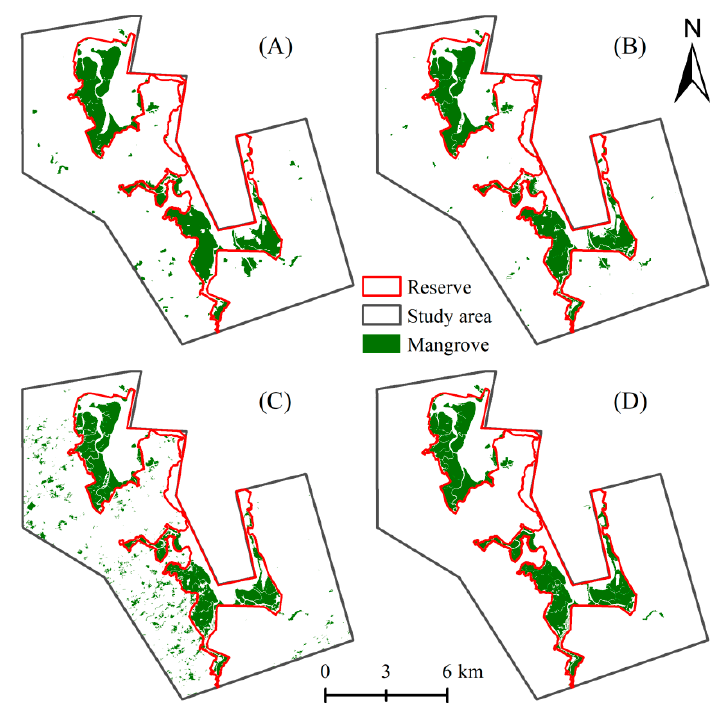
Figure 3. Comparison of ( A ) Landsat 8, ( B ) Sentinel-2, ( C ) Pléiades-1, and ( D ) manual visual interpretation based on field survey using Pléiades-1 image for mangrove extent classifications.